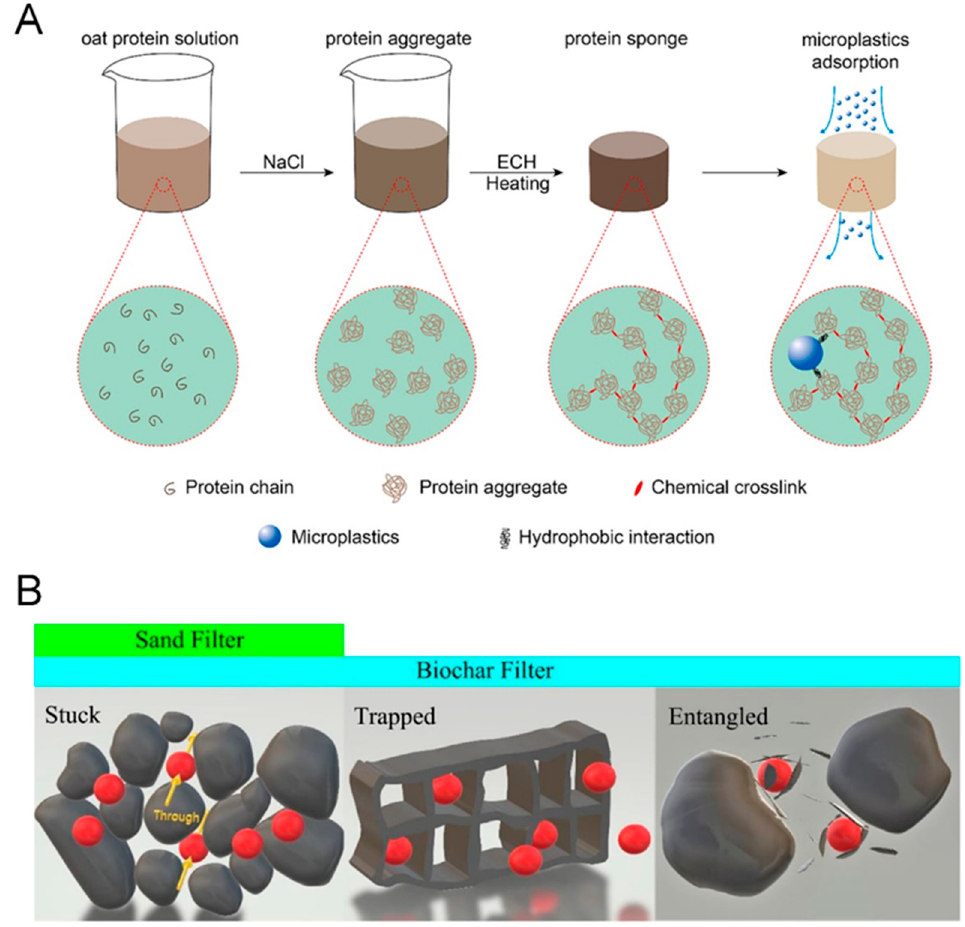
Figure 8. ( A ) Schematic illustration of the preparation procedure of a hydrophobic protein sponge and its application in MP removal [88]. ( B ) Three mechanisms for MP removal (i.e., Stuck, Trapped, and Entangled) [86]. All figures are reprinted with copyright permissions from the respective references.